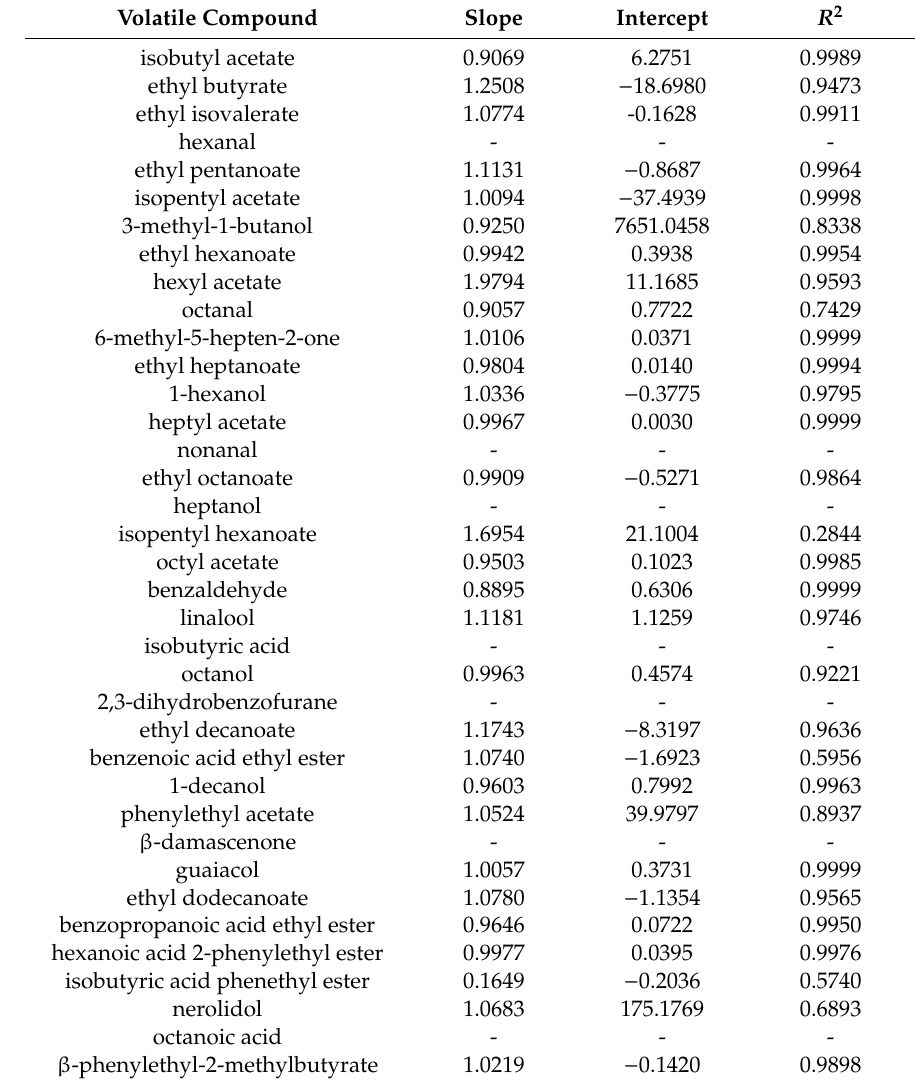
Table 4. Parameters of the linear regression obtained by representing concentration values determined with HSSE against concentration values determined with SBSE: [SBSE] = slope [HSSE] +